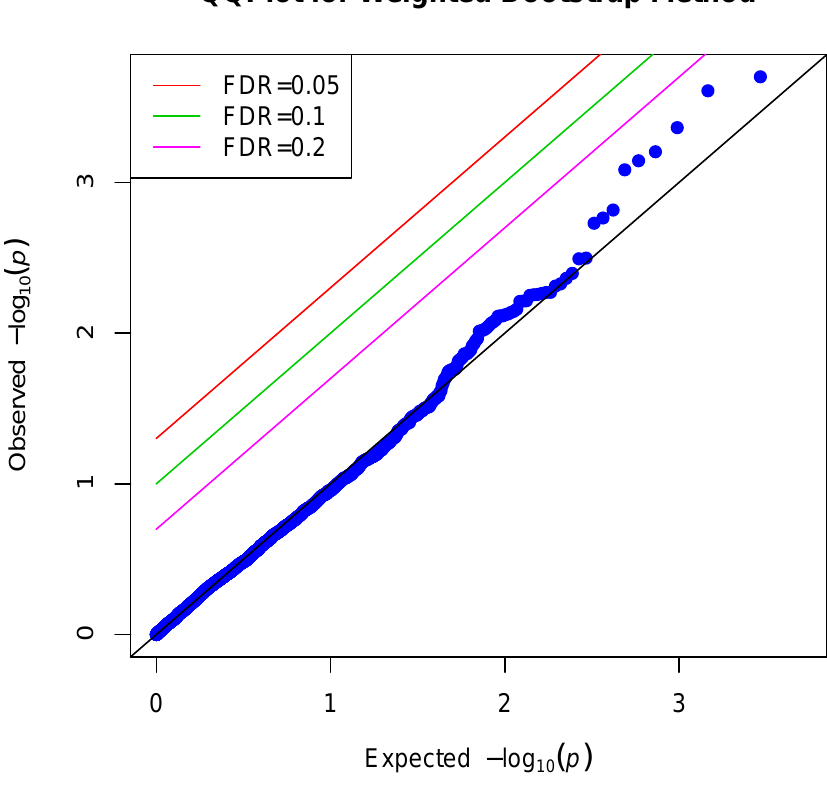
Figure 2. Q–Q plot for the weighted bootstrap